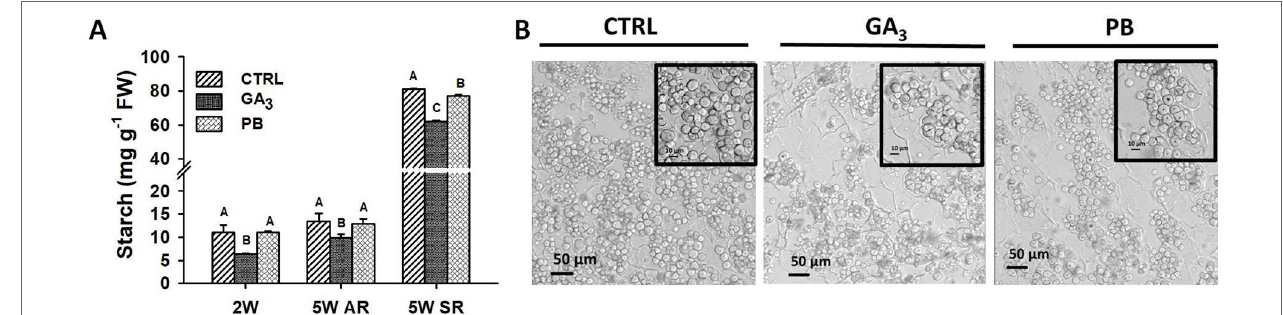
FiGURe 7 | Effect of GA 3 application on starch level (a) , and starch granules accumulation (B) in sweetpotato “ Georgia Jet ” roots. Starch level was quantified in roots collected at two and five weeks (2W and 5W, respectively) after planting. At 5W, both adventitious roots (AR) that did not develop into storage-root (SR), and SR were analyzed. Bars in (a) represent mean of three independent biological replicates (each representing roots pooled from four plants) ± SE. Significance analysis was performed by using student’s t-test ( P ≤ 0.05 ), where unlike letters represent significant differences between treatments within a group. Cross sections of SR collected at 5W of development, representing six independent biological replicates (plants), are given in (B) as viewed under a confocal microscope focusing on starch granules. Scale bar = 50 µm and 10 µm (in inset). Control (treated with water); GA 3 , application of 50 ppm gibberellic acid 3 for two weeks; PB, application of 5 ppm paclobutrazol for two